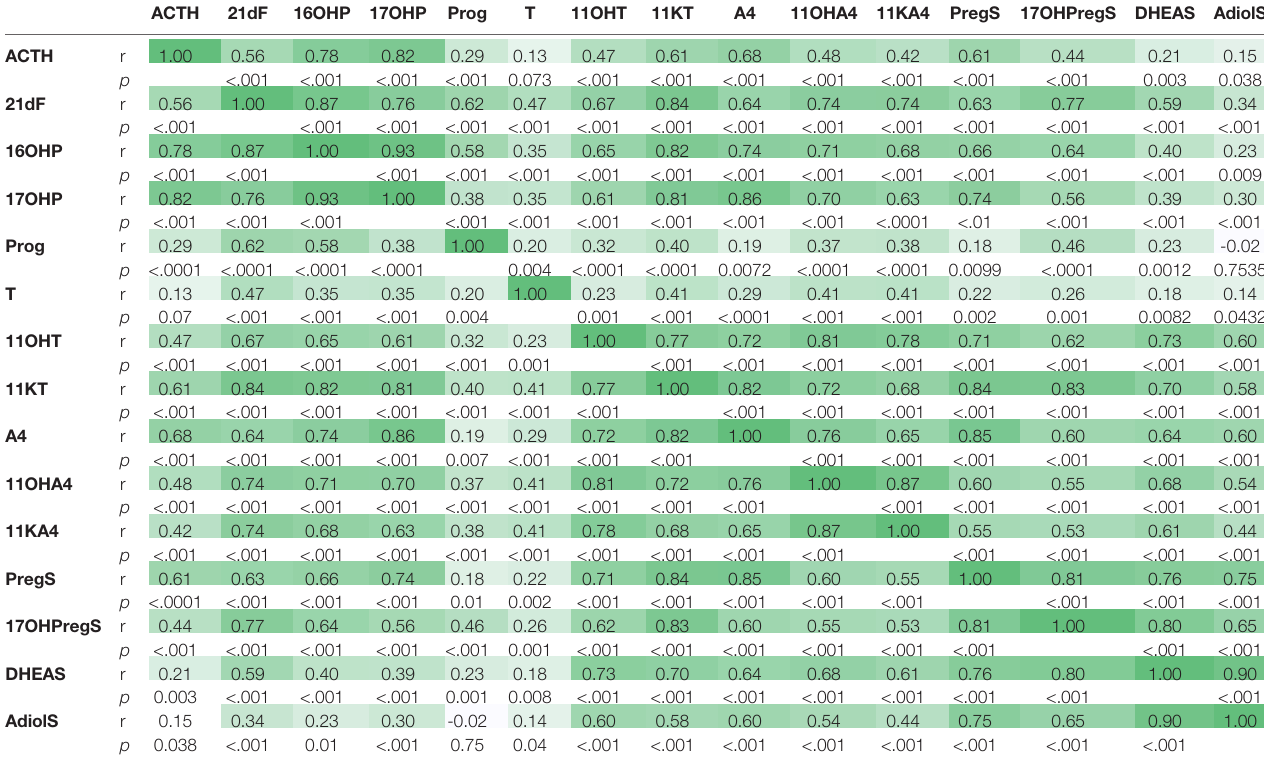
TABLE 3 | Correlations between steroids and